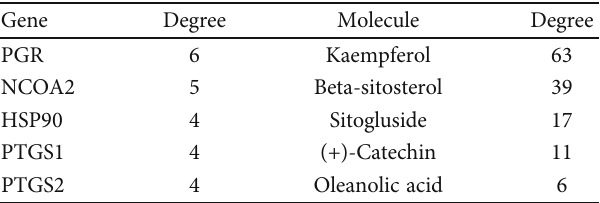
Table 3: Degree of top 5 chemicals and target proteins of PRA.